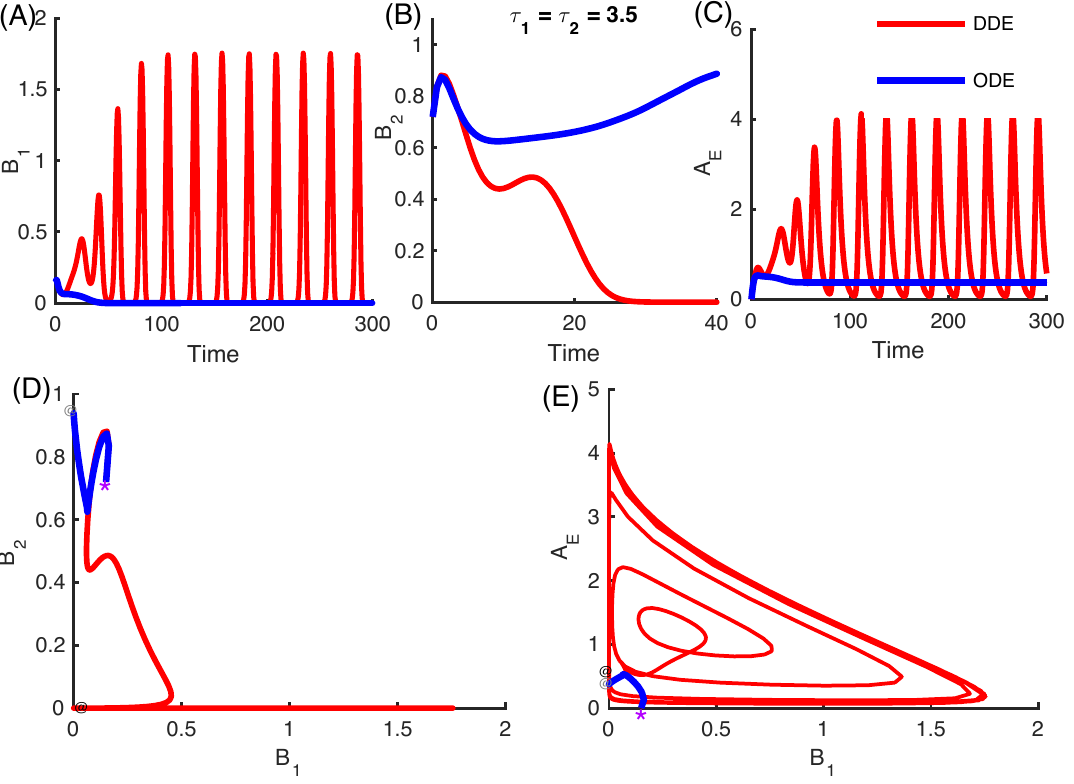
Figure 10. Effect of large time delays ( τ 1 = τ 2 = 3.5) in the competition M2 model (41)–(43). The introduction of time delays in the system induces oscillatory behaviors of both bad bacteria ( B 1 ) and immune cytokines ( A E ) and the extinction of good bacteria. ( A – C ) Time courses of the populations of bad bacteria ( B 1 in (A)) and good bacteria ( B 2 in (B)) and the immune response ( A E in (C)) in the absence (blue solid lines) and presence (red dashed lines) of time delays; ( D ) the corresponding trajectories of B 1 and B 2 in (A,B) in the phase plane; ( E ) the corresponding trajectories of B 1 and A E in (B,C) in the phase plane; Initial condition: B 1 ( 0 ) = 0.15, B 2 ( 0 ) = 0.72, A E ( 0 ) = 0.0. All other parameters are fixed as in Table 4 (Type